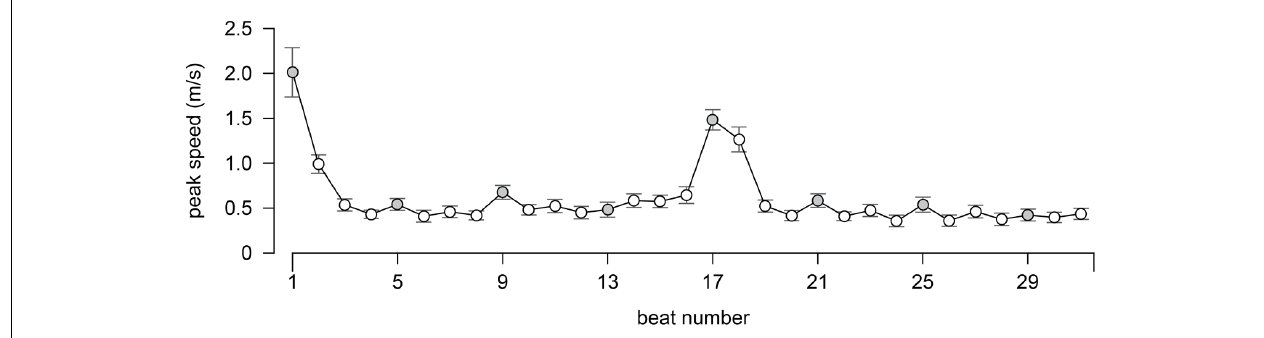
FIGURE 5 |The average peak speed of the bow movement directly proceeding to the acoustic onset. The error bars represent one standard